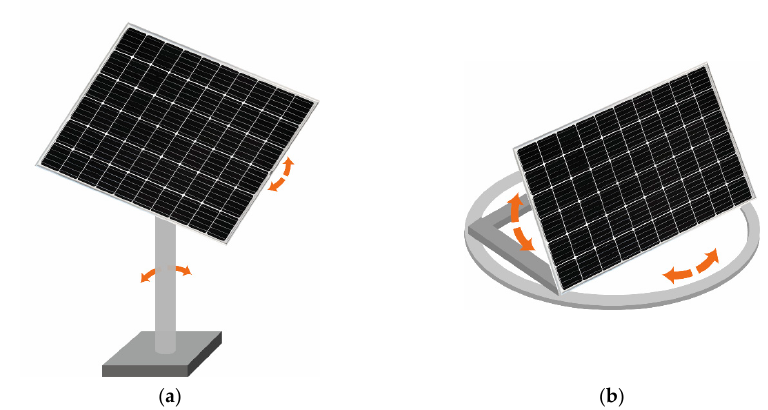
Figure 7. Dual-axis photovoltaic tracking systems: ( a ) TTDAT and ( b ) AADAT.